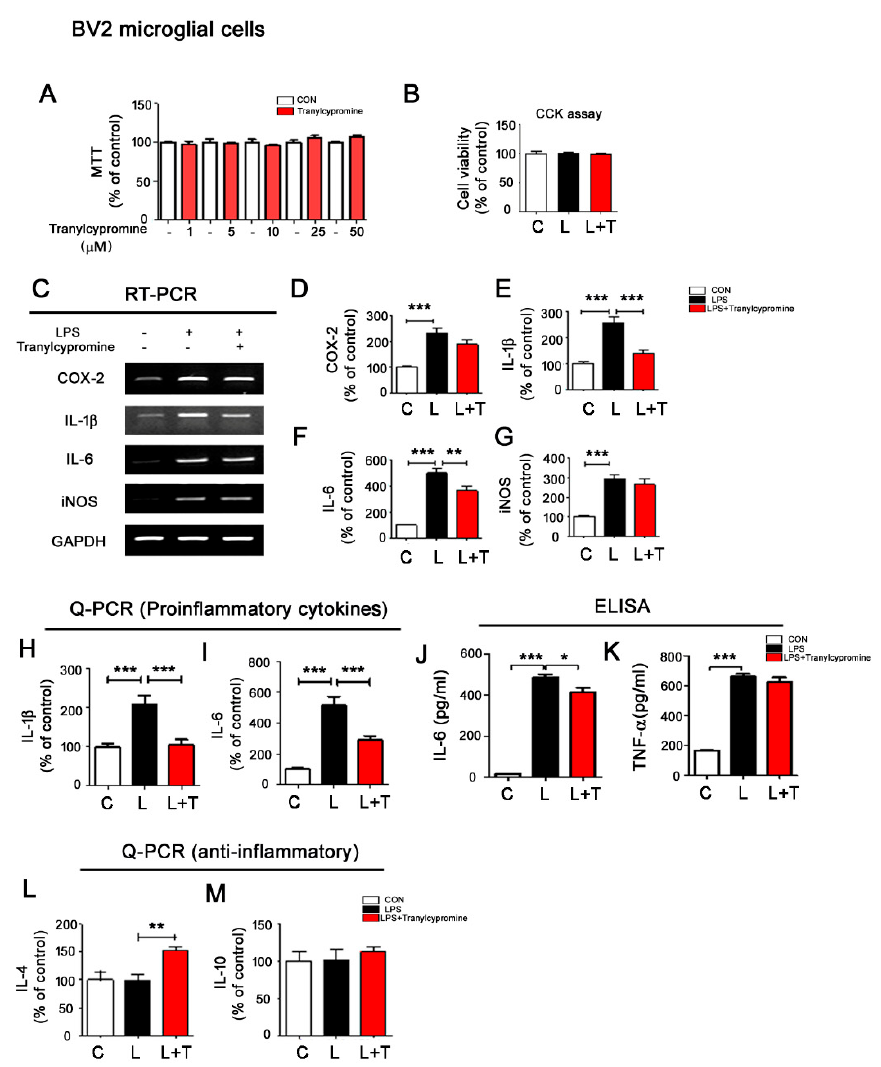
Figure 1. Post treatment with tranylcypromine selectively regulates LPS-evoked proinflammatory cytokine levels in BV2 microglial cells. ( A ) BV2 cells were treated with vehicle (1% DMSO) or tranylcypromine (1, 5, 10, 25, and 50 µ M) for 24 h, and cell viability was measured ( A , n = 12 for each dose). ( B ) BV2 microglial cells were pretreated with LPS (1 µ g / mL) or PBS for 30 min and treated with vehicle (1% DMSO) or tranylcypromine (5 µ M) for 5.5 h, and CCK assays were performed ( n = 24 / group). ( C – I ) BV2 microglial cells were pretreated with LPS (1 µ g / mL) or PBS for 30 min and treated with vehicle (1% DMSO) or tranylcypromine (5 µ M) for 5.5 h, and proinflammatory cytokine levels were measured by RT-PCR ( n = 16 / group) or Q-PCR (IL-1 β and IL-6; n = 10 / group). ( J , K ) BV2 microglial cells were pretreated with LPS (200 ng / mL) or PBS for 30 min and treated with vehicle (1% DMSO) or tranylcypromine (5 µ M) for 23.5 h, and ELISA was performed ( n = 8 / group). ( L , M ) BV2 microglial cells were pretreated with LPS (1 µ g / mL) or PBS for 30 min and treated with vehicle (1% DMSO) or tranylcypromine (5 µ M) for 5.5 h, and anti-inflammatory cytokine levels were measured by real time-PCR ( n = 4 / group). * p < 0.05, ** p < 0.01, *** p < 0.001. CON and C, control; L, LPS; L + T, LPS +